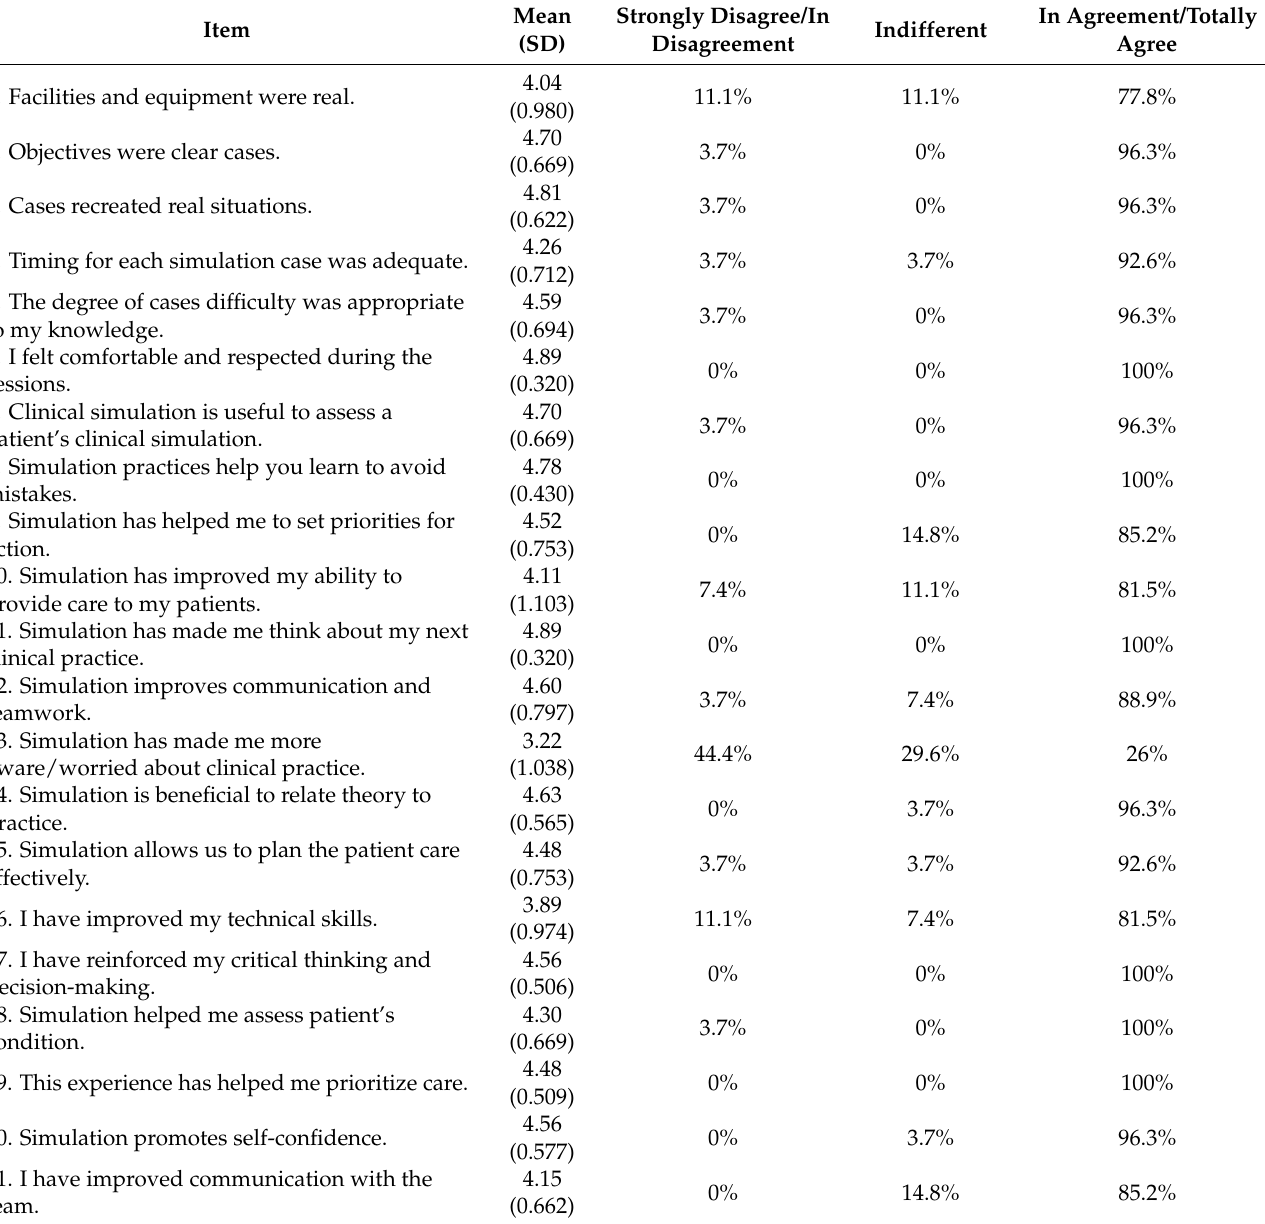
Table 1. Descriptive data and frequencies obtained in our sample ( n = 27) in each item included in the satisfaction questionnaire. Item